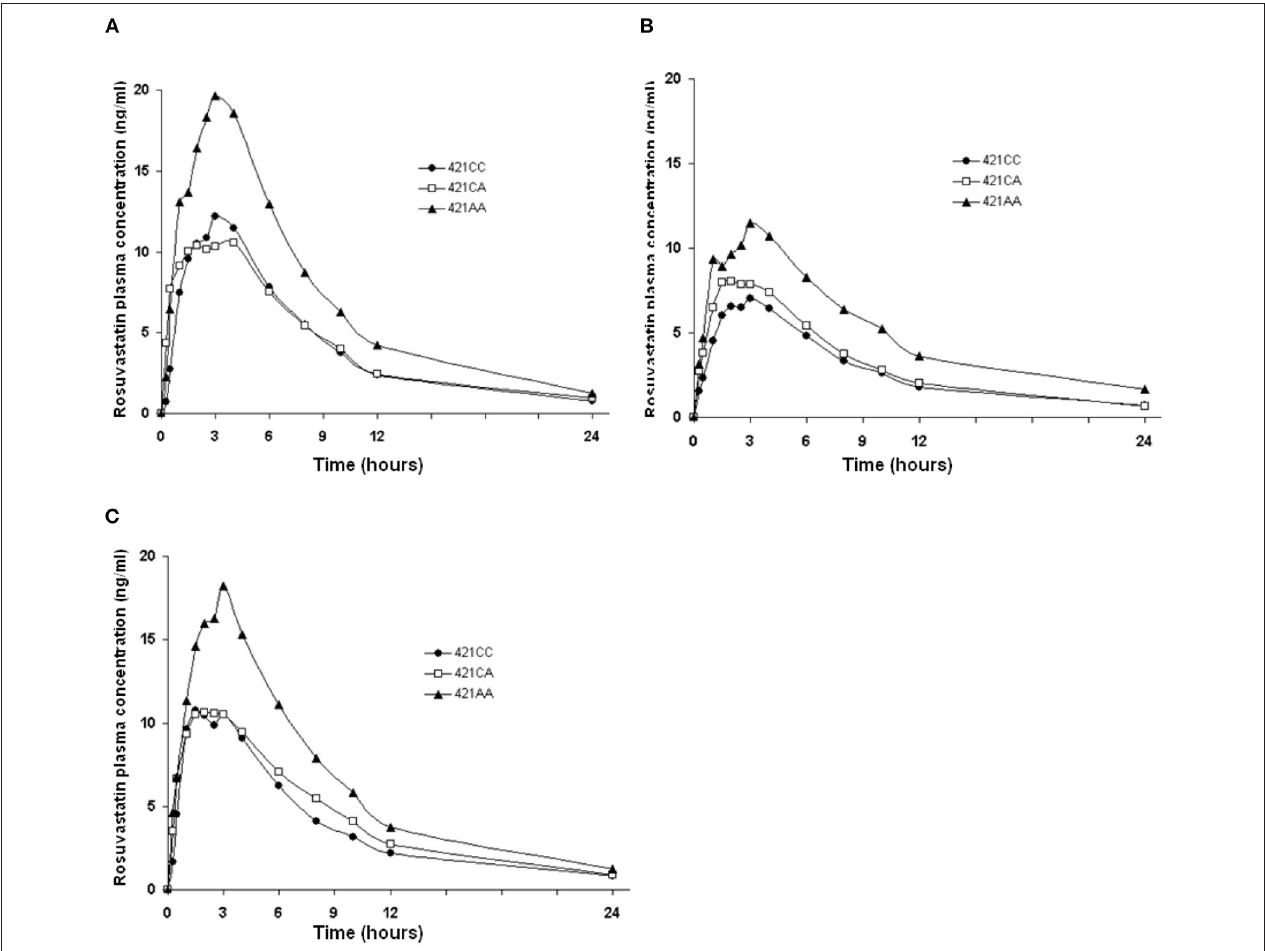
FIGURE 2 | Effect of the ABCG2 421C > A polymorphism on the pharmacokinetics of rosuvastatin at baseline and after intake of green tea and soy isoflavones. Data are arithmetic mean. P < 0.05 for 421AA vs. 421CC + 421CA in all three phases. (A) , Baseline; (B) , After green tea extract; (C) , After soy